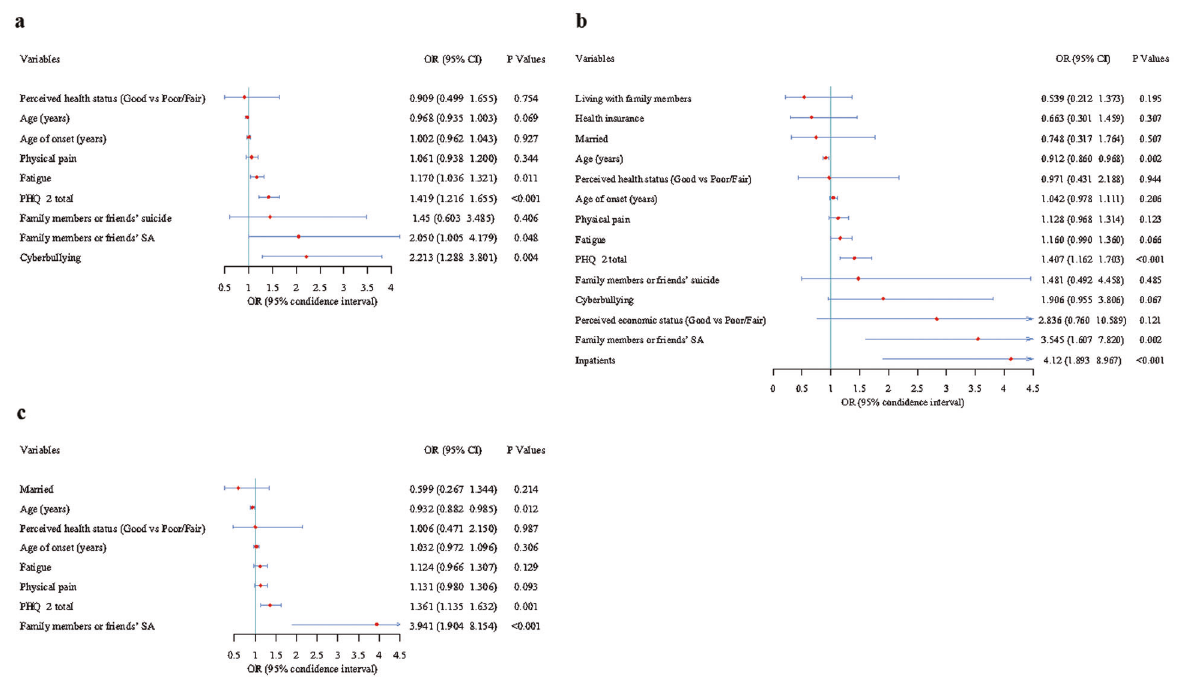
Fig. 3 Independent correlates of suicidal ideation, suicide plan and suicide attempt in patients with schizophrenia by multiple logistic regression analyses. Note: a , suicidal ideation; b , suicide plan; c , suicide